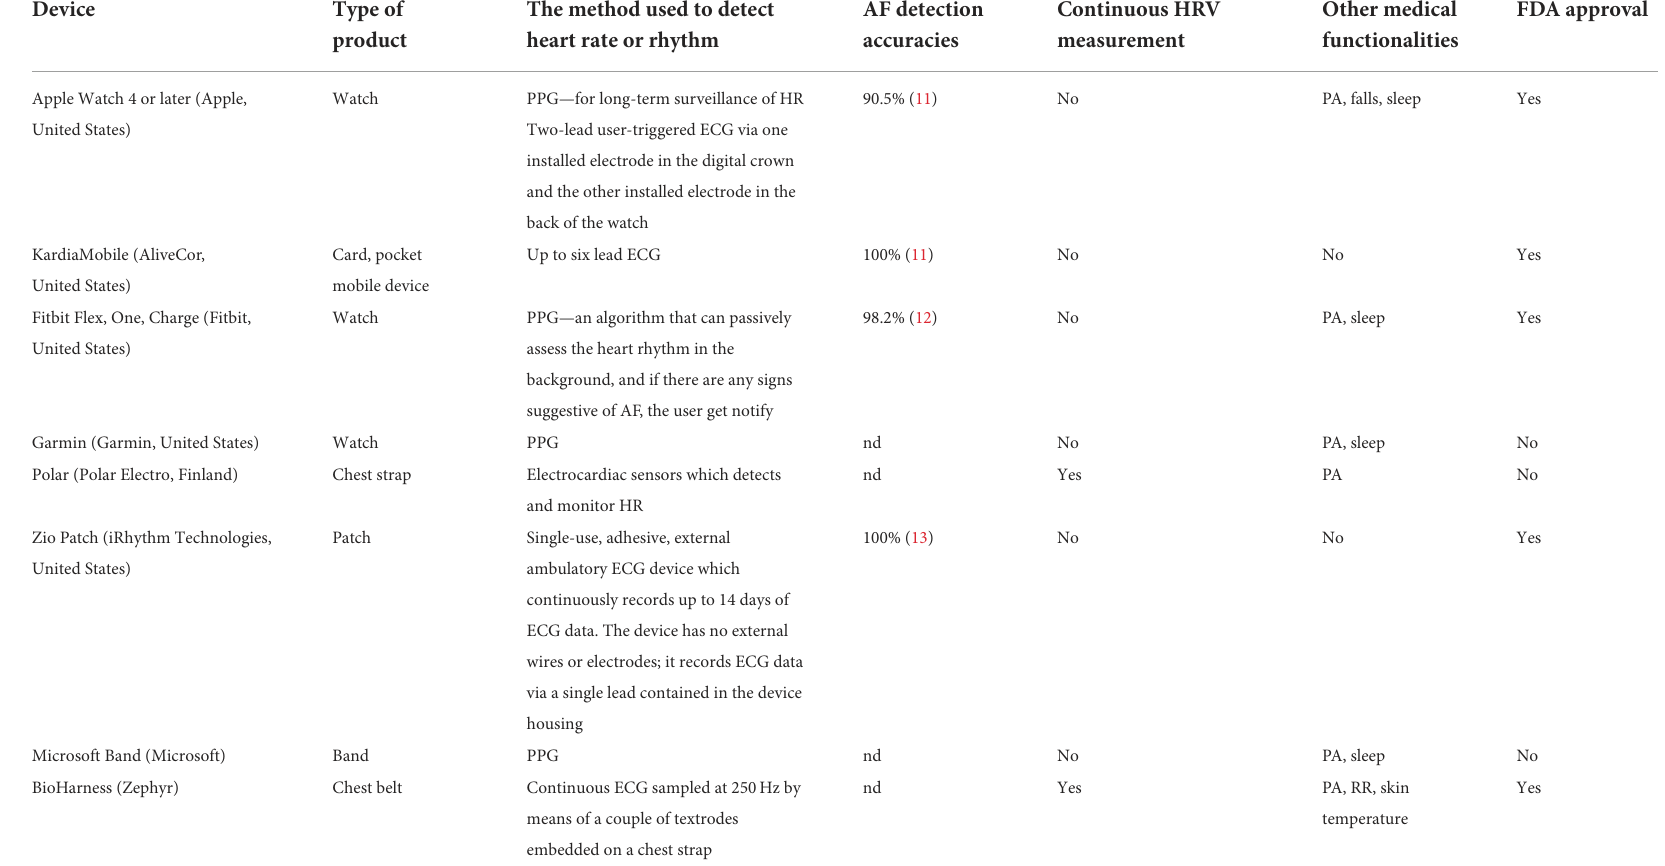
TABLE 1 Comparison of the most popular devices used for mobile rhythm